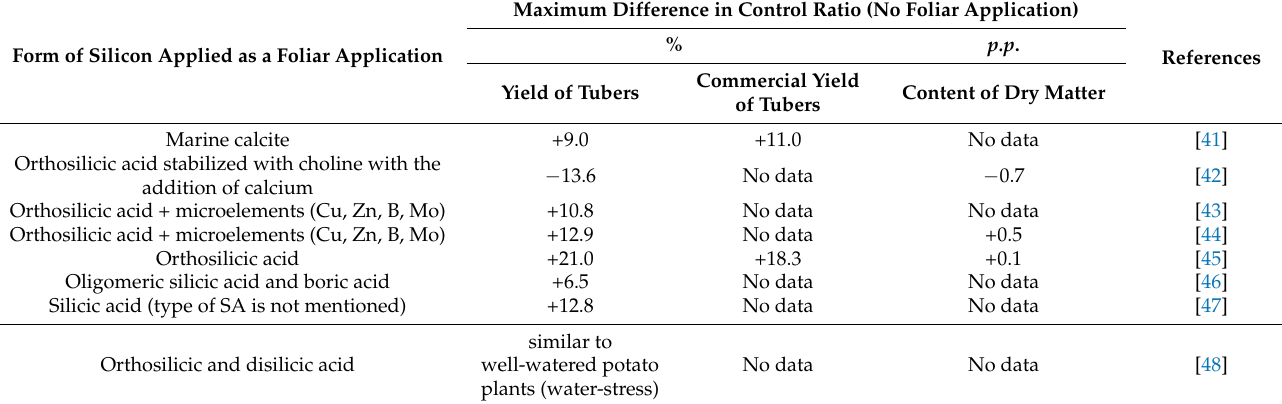
Table 7. Results of studies on foliar application of various forms of silicon in the cultivation of potato. Maximum Difference in Control Ratio (No Foliar Application) References% p.p . Form of Silicon Applied as a Foliar Application Commercial Yield Yield of Tubers Content of Dry Matter of Tubers Marine